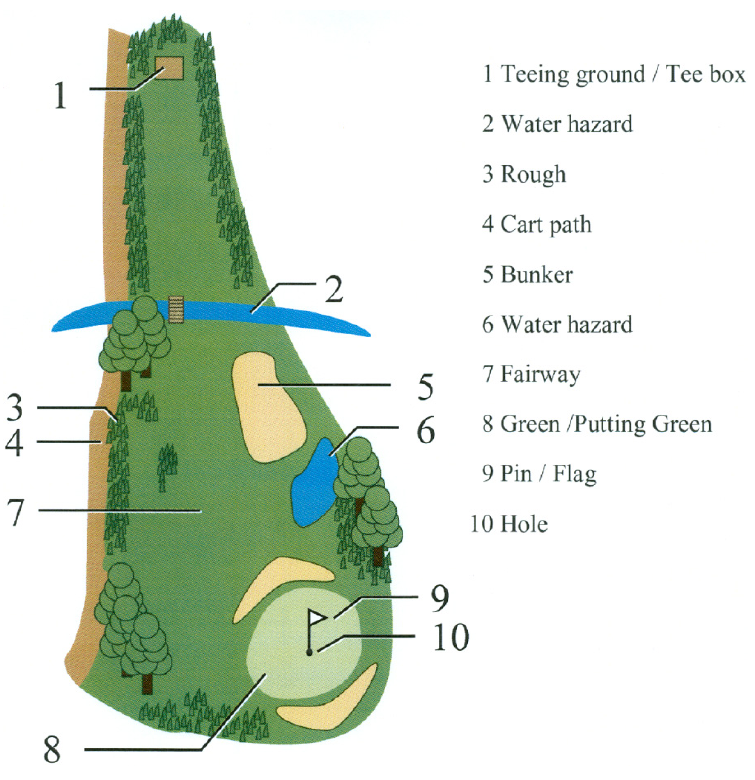
Figure 1. Golf course